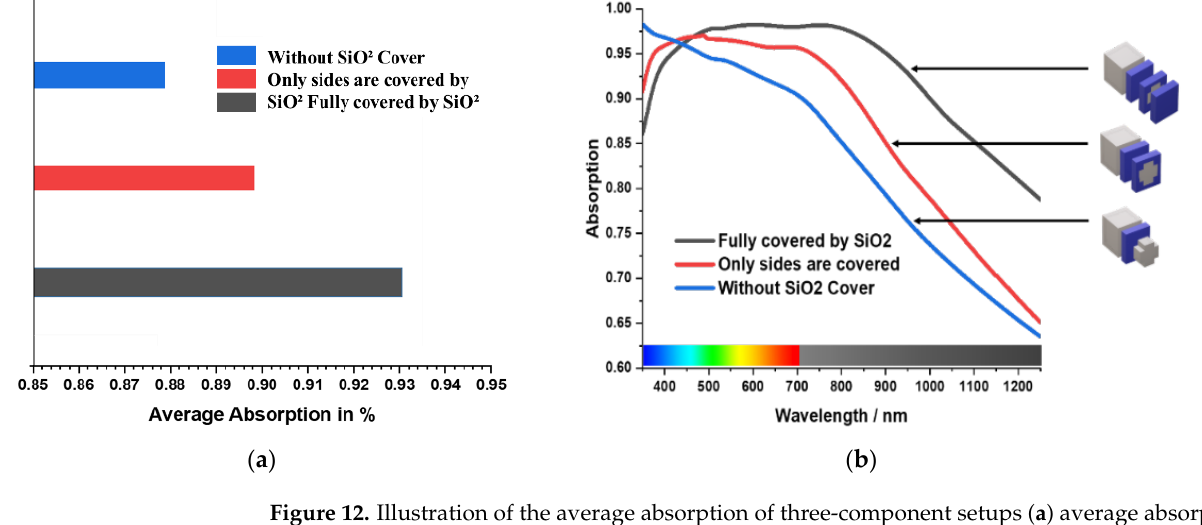
Figure 12. Illustration of the average absorption of three-component setups ( a ) average absorption ( b ) total absorption.